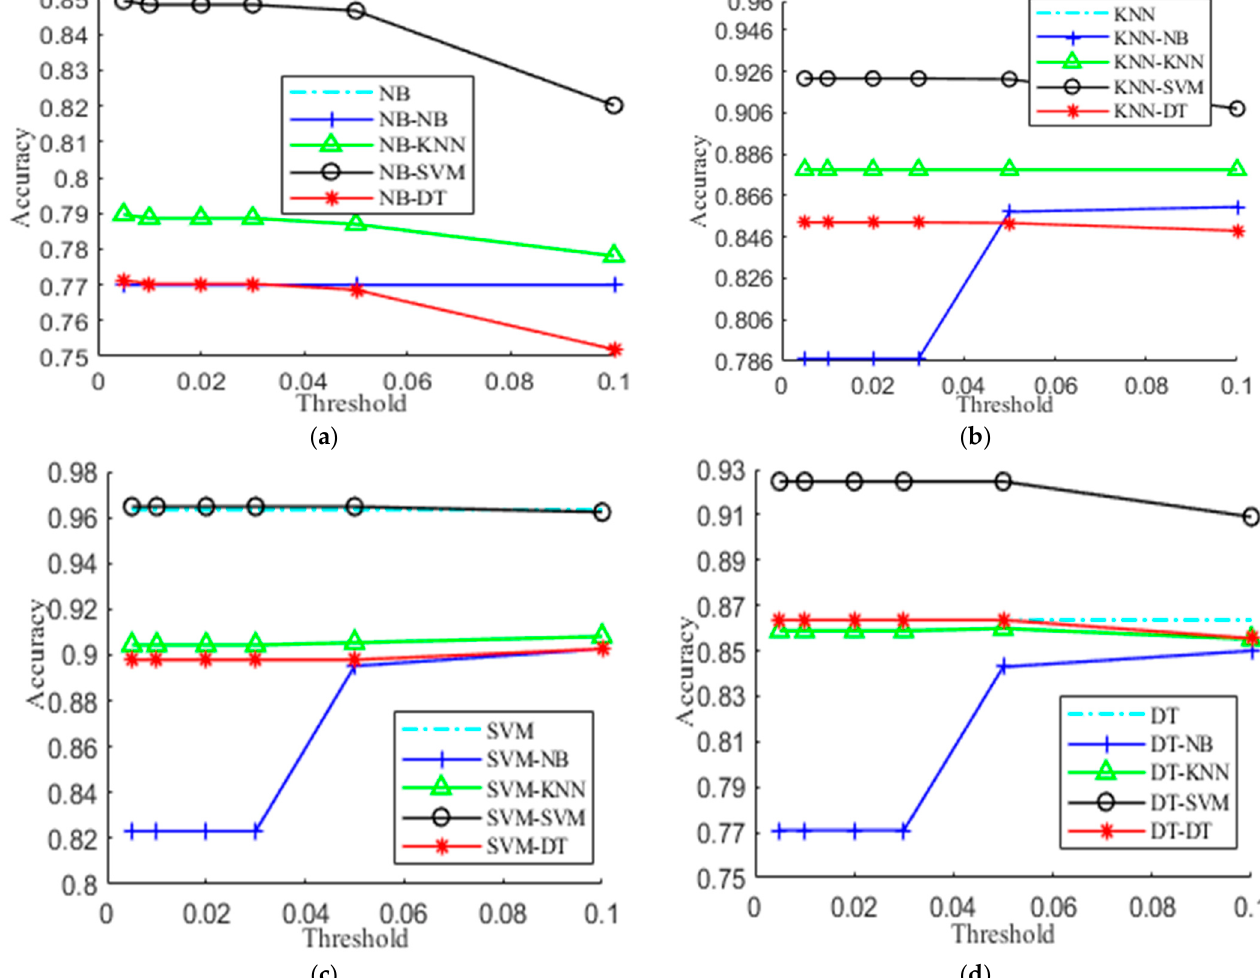
Figure 5. Accuracy vs. different thresholds. ( a ) NB; ( b ) KNN; ( c ) SVM; ( d ) DT.